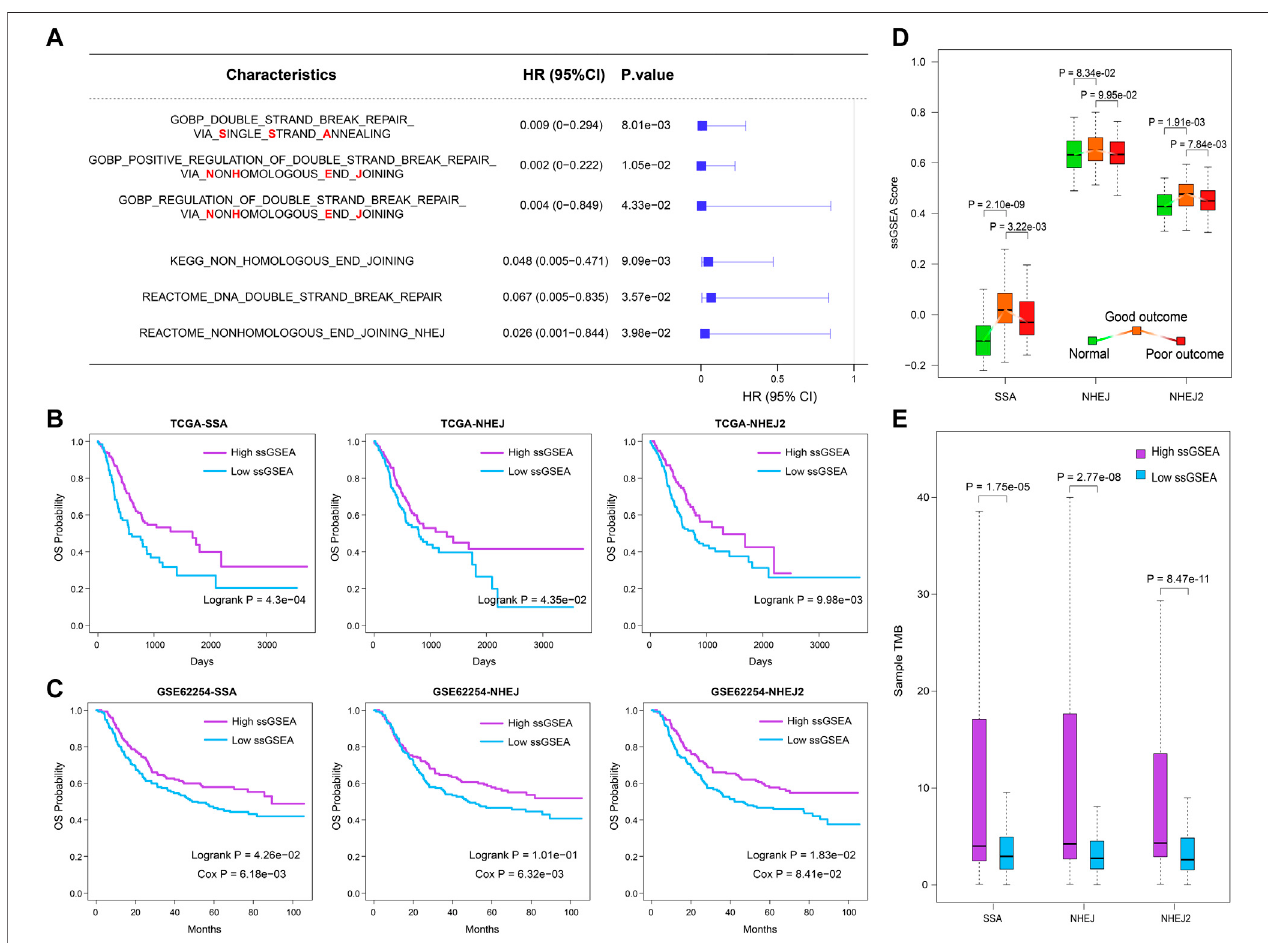
FIGURE 1 | SSA and NHEJ DNA repair approaches are primary protection factors for overall survival in GC patients. (A) The prognostic value of SSA and NHEJ DNA repair process evaluated by univariate Cox proportional-hazards regression model. (B,C) Samples with higher ssGSEA scores of SSA or NHEJ have better clinical outcomes in the TCGA cohort and GSE62254 dataset. (D) ssGESA scores of SSA and NHEJ processes increase fi rst and then decline in normal, good outcome, and poor outcome samples. (E) Samples with a higher ssGSEA score of SSA or NHEJ are with more somatic mutations.